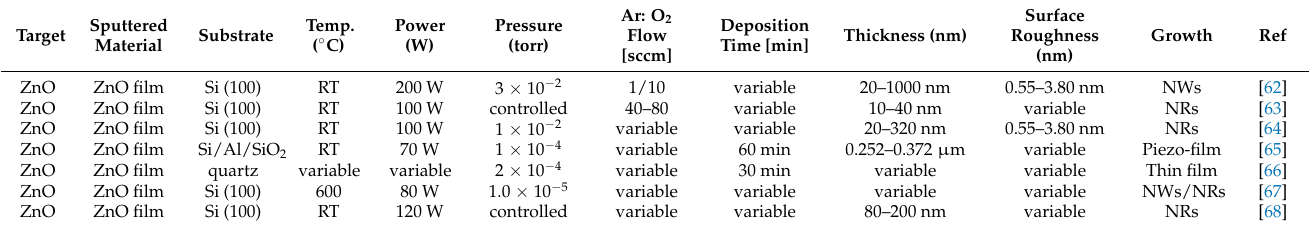
Table 1. Growth deposited parameters of sputtered ZnO thin film on substrates, with different surface roughness values and